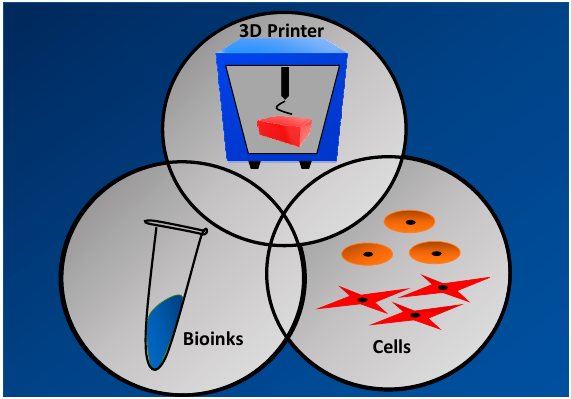
Figure 3. The elements needed for 3D bioprinting process.